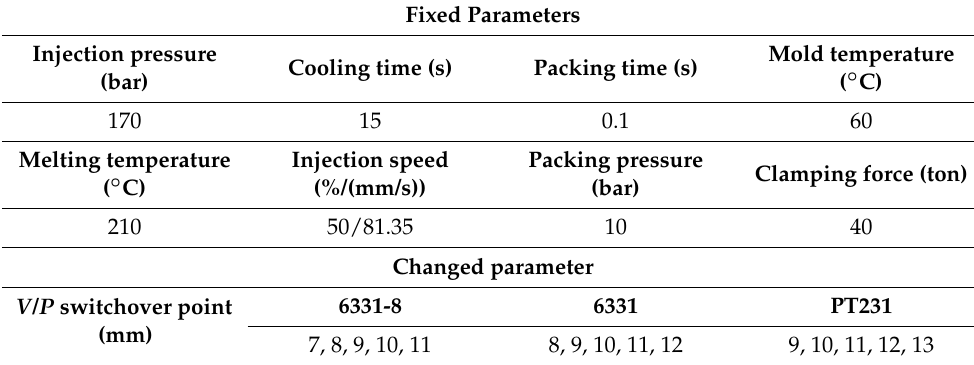
Table 2. V/P switchover point experiment parameters.